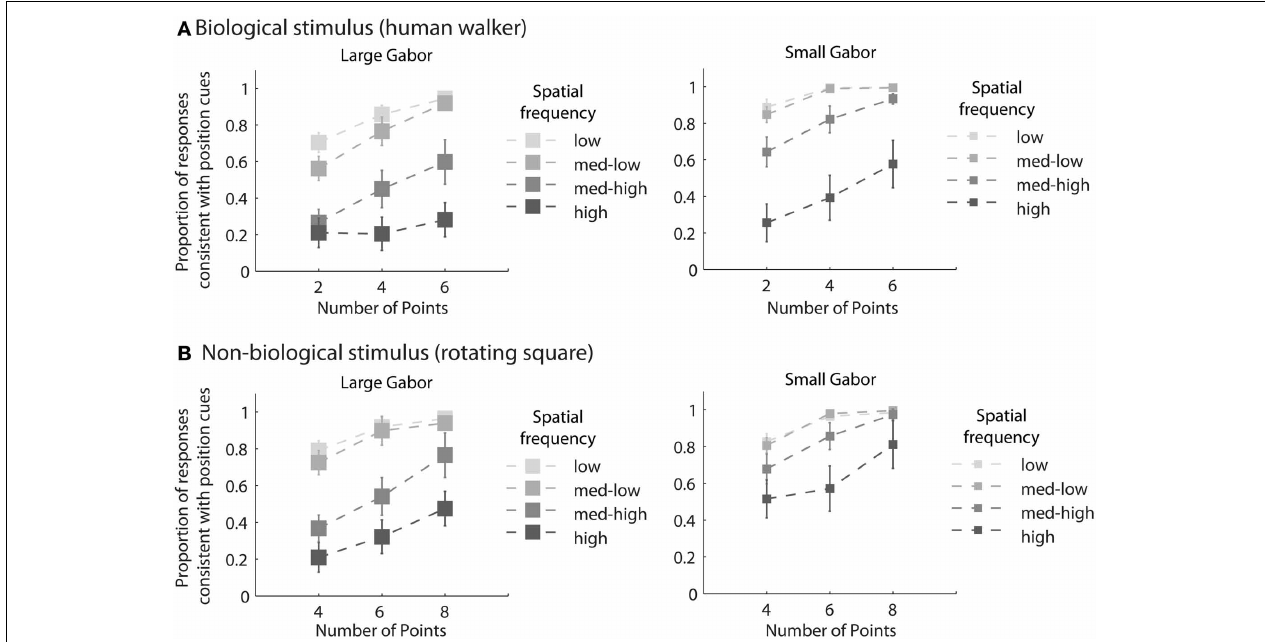
med-high, and high conditions). The y-axis shows the proportion of responses that were consistent with the stimulus movement direction defined by the positions of the elements. Since all trials were of the type with incongruent orientation and position cues, values closer to zero indicate perceptual reversals of stimulus movement direction consistent with orientation cues. Error bars represent